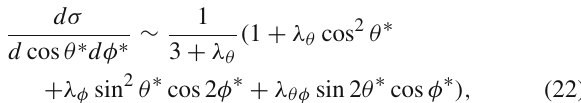
√ s = 8 TeV (right panel). Notation